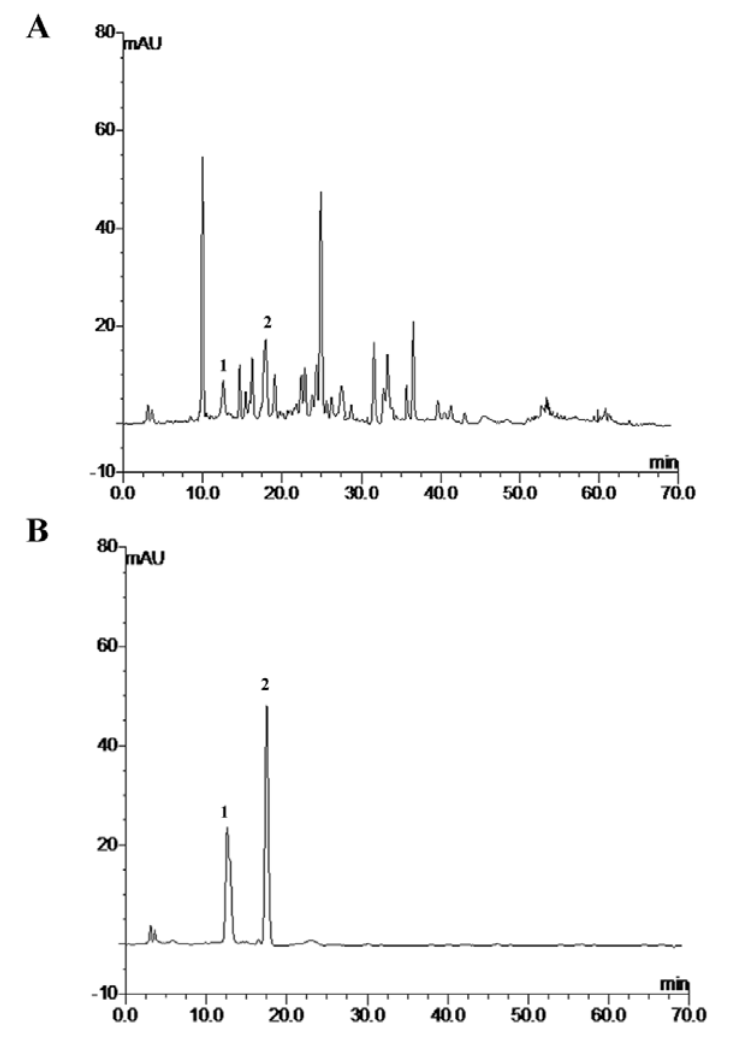
Figure 5. HPLC profiles of EESB ( A ) and a control sample ( B ). The mobile phase consisted of methanol:water:acetic acid = 35:61:4. The control sample was composed of scutellarein (peak 1) and baicalin (peak